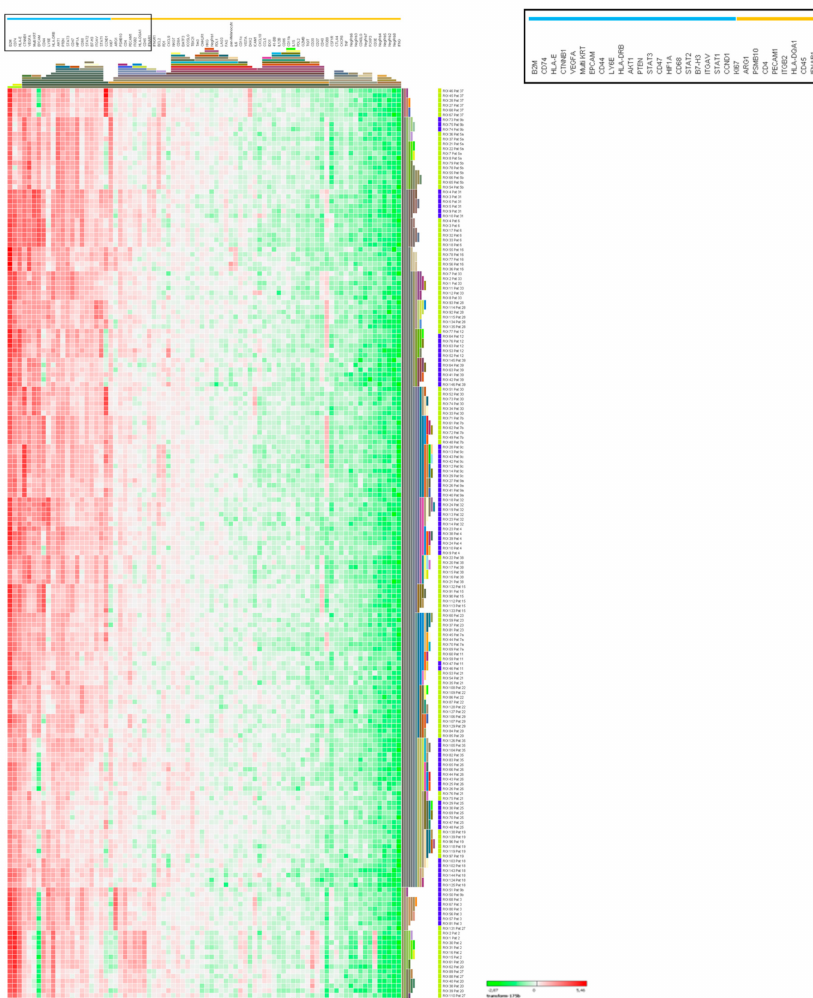
Figure 5. RNA abundance heatmap of genes related to the immune response in NET G3 and NEC. The columns represent the log10 transformation of 85 gene probes. The red to green hues represent the gradient high to low RNA abundance. The values used are normalized to the geomean of 5 housekeeping proteins. Rows represent ROI ID and the bar on the right is color coded for NEC (yellow) and NET G3 (blue). The hierarchical gene clustering shows the high to low RNA